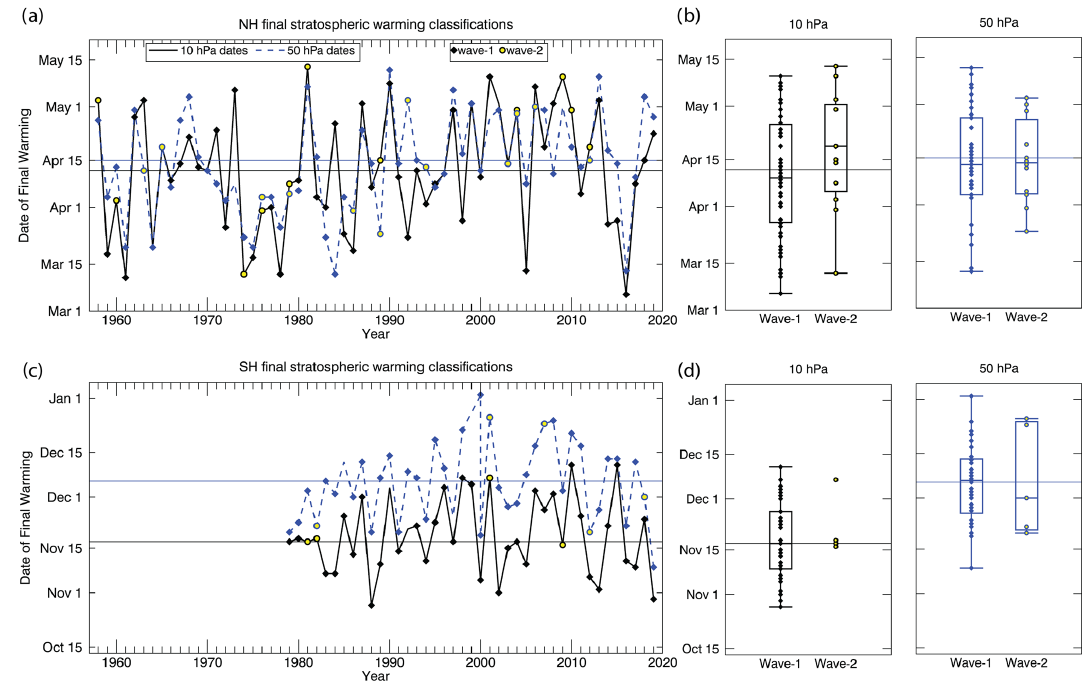
Figure 1. (a, c) Dates of FSWs in the NH (1958–2019) and SH (1979–2019) using JRA-55 reanalysis based on zonal-mean zonal winds below 0ms − 1 at 10hPa (solid black line) and below 5 (10)ms − 1 at 50hPa in the NH (SH) (dashed blue line). Symbols indicate the wave classification of the event. (b, d) Dates of FSWs at 10 and 50hPa grouped by either wave-1 or wave-2 classification. The whiskers show the earliest/latest dates, the top/bottom of the box shows the upper and lower quartiles, and the solid line shows the median date for each classification. The horizontal lines indicate the median date (based on the 1979–2019 period) for all final warmings in each hemisphere.